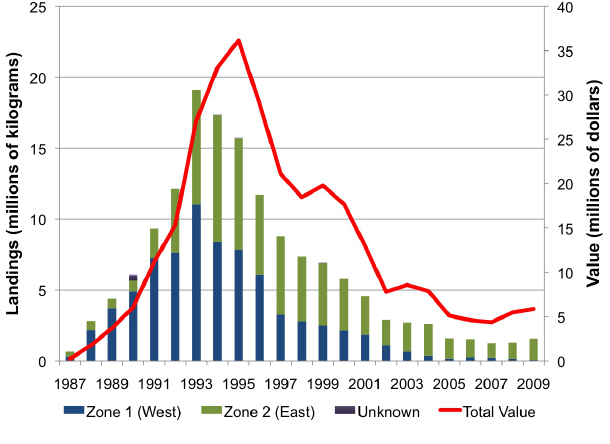
Fig. 1 . Sea urchin landings in Maine, and value by Zone, from 1987 to 2009. Source: Maine Department of Marine